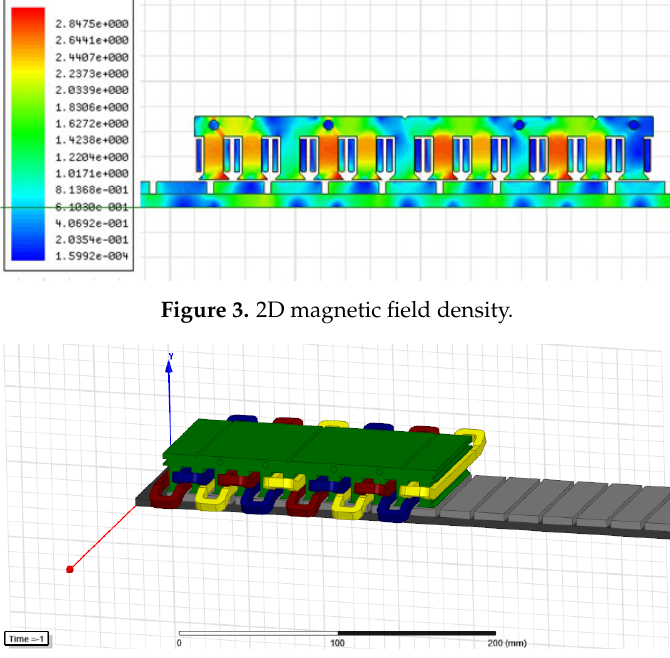
Figure 4. 3D FEA model in ANSYS Maxwell.